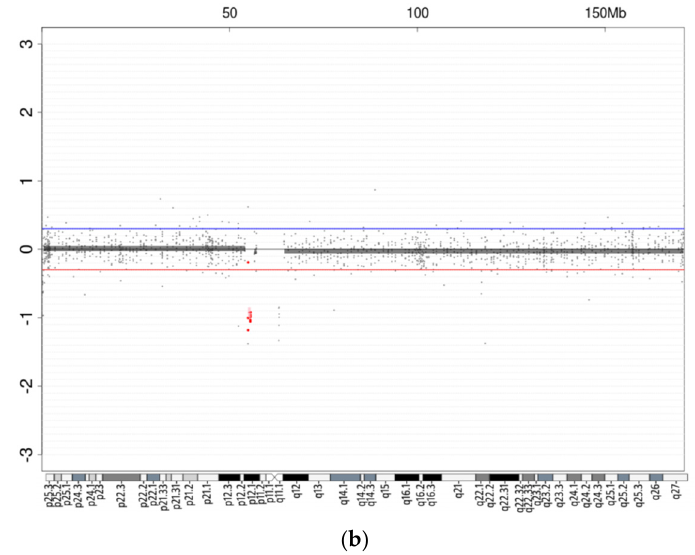
Figure 4. Chromosomal microarray analysis (CMA) using blood lymphocytes. Microarray studies revealed three deleted loci on chromosome 6, including one inherited deletion in 6p12.1 and two deletions in 6q14.1 and 6q16.1~q16.3 region in the child ( a ), and one deletion in 6p12.1 in the mother ( b ). The “Log 2 Ratio = 0” represents a normal CNV result; “Log Ratio < − 0.3” represents a deletion 2 (below red line); and “Log 2 Ratio > 0.3” represents a duplication (above blue